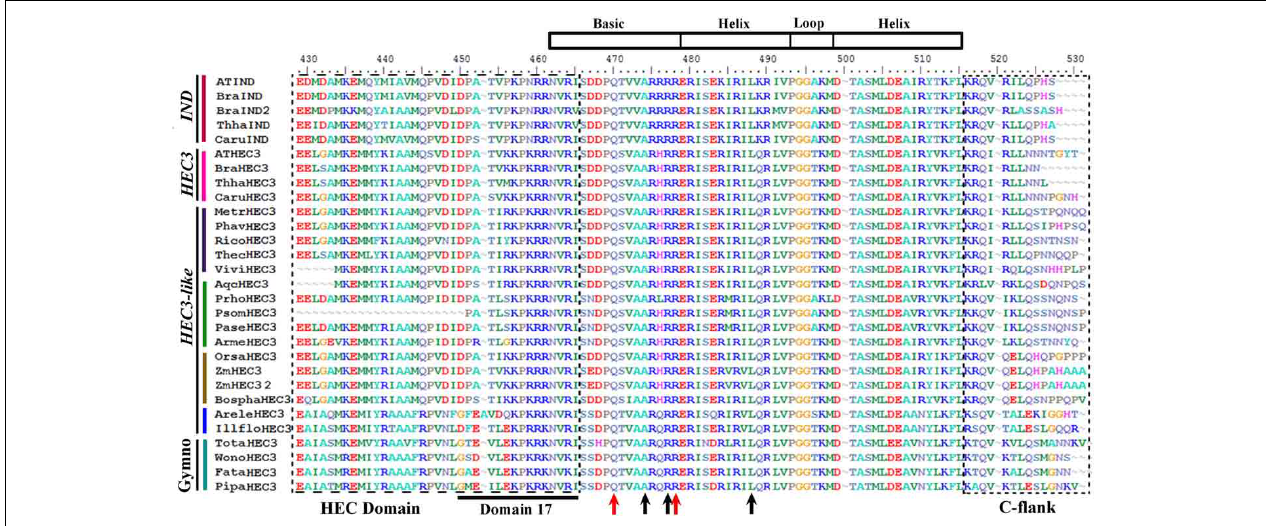
FIGURE 8 | Alignment of the bHLH domain of HECATE3/INDEHISCENT proteins (labeled with the clade names they belong to). Colors to the left of the sequences indicate the taxa they belong to as per color key in Figure 9 . The bHLH was drawn based on Toledo-Ortiz et al. (2003) and in our alignment corresponds with positions N462-L515. Boxed to the left is the N-flank of the bHLH domain rich in hydrophobic aminoacids (called the HEC domain by Kay et al. (2013) and includes domain 17 by Pires and Dolan (2010); note that to Kay et al. (2013) the bHLH domain starts at S462 right after the end of the HEC domain). Black arrows in the bHLH